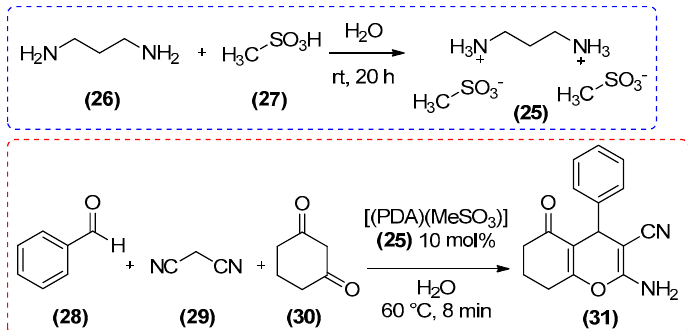
catalytic activity in the synthesis of 2-amino-3-cyano-4 H